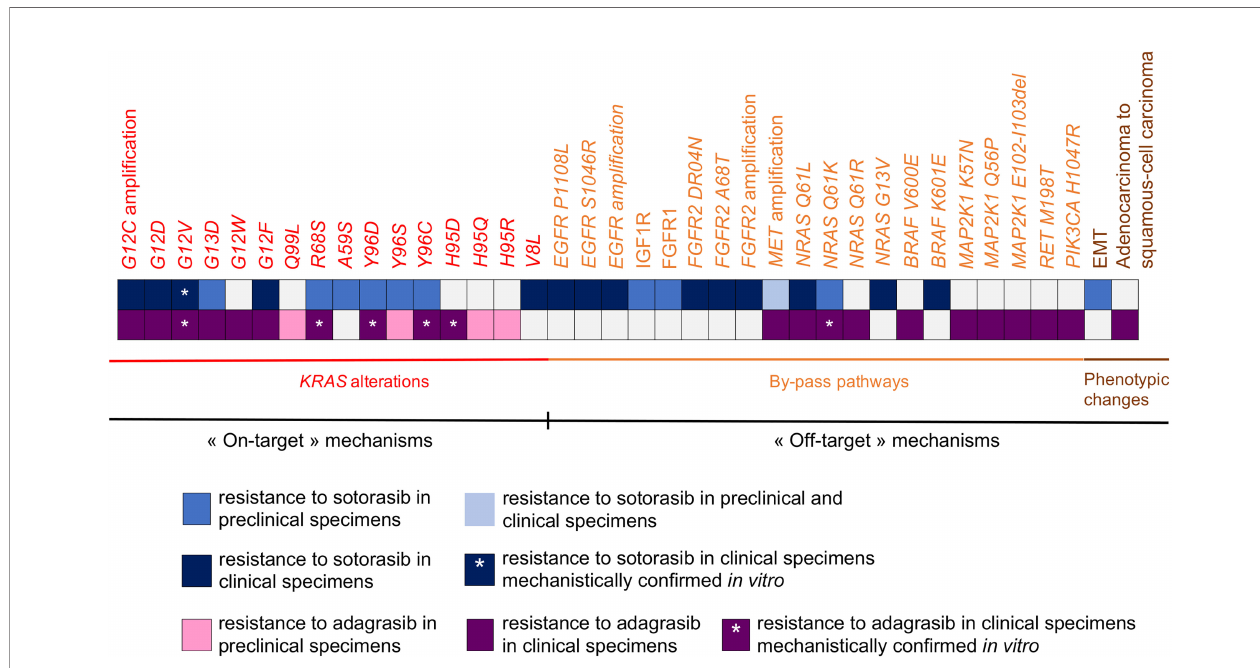
FIGURE 2 | Synthesis of biological mechanisms of acquired resistance to sotorasib and adagrasib described in pre-clinical specimens and clinical specimens.